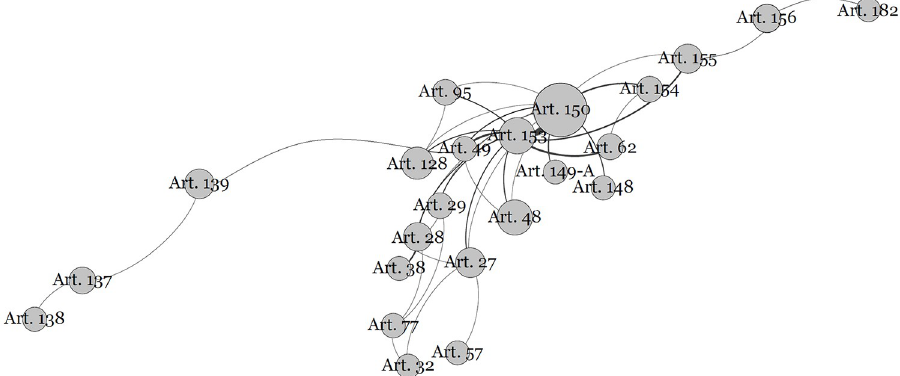
Fig 5. Limitations on the power to tax and its constitutional text connections. Item II of Article 150, which prohibits the differential treatment of taxpayers by profession, is referenced in other articles, especially for state deputies (Article 27); governors and secretaries (Article 28); mayors (Article 29); servants (Article 37); ministers of the federal supreme court (Article 48); deputies, senators, the president and ministers (Article 49); judges (Article 95); and prosecutors (Article